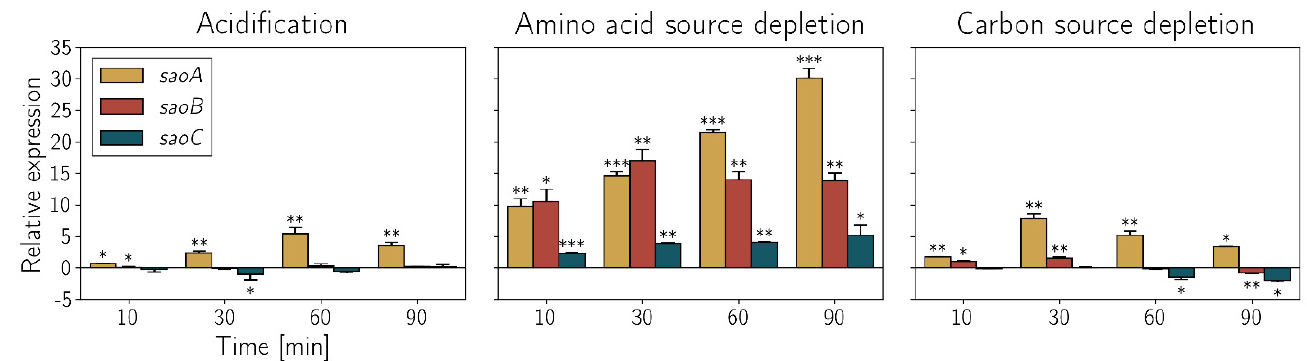
Figure 4. Expression changes of saoABC operon genes in S. aureus CH91 strain manifested repro- ducibly in three distinctive stress conditions, including acidification as well as depletion of amino acid or preferential carbon sources, measured with RT-qPCR ( n = 3) in reference to transcripts of gyrase B ( gyrB ). In all conditions, particularly elevated expression of saoA is observed. Similar changes are observed for saoB in the case of amino acid source depletion. Preferential carbon source depletion leads to decreased expression of saoB and saoC. * p ≤ 0.050, ** p ≤ 0.010, *** p ≤